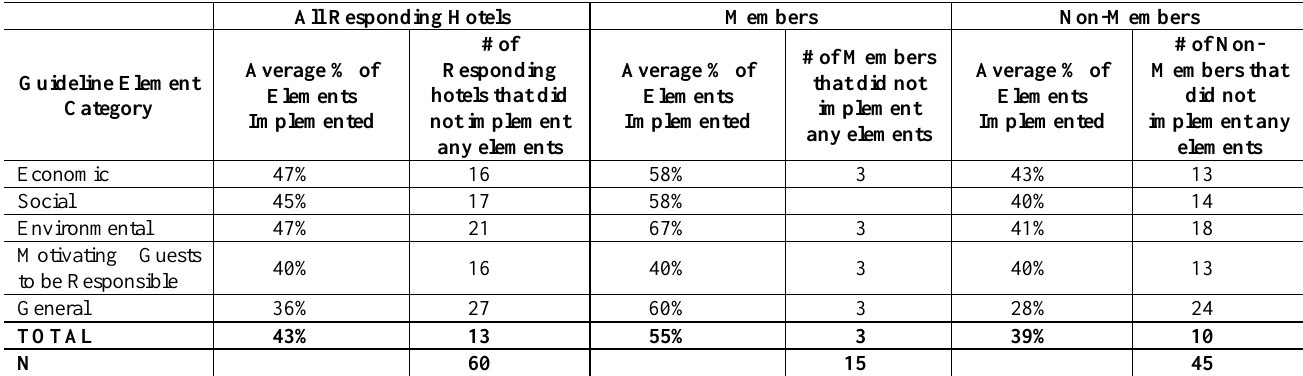
Table 3: Implementation of responsible tourism guideline elements